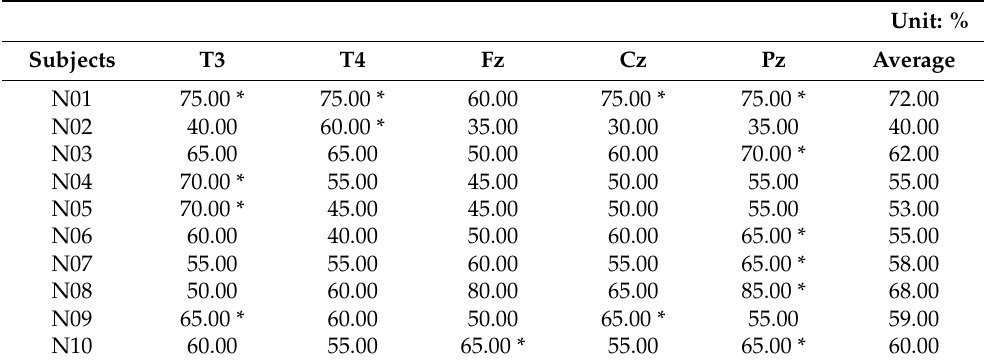
Table 3. The average accuracies by component P300 of the experimental trial using mental Shadowing